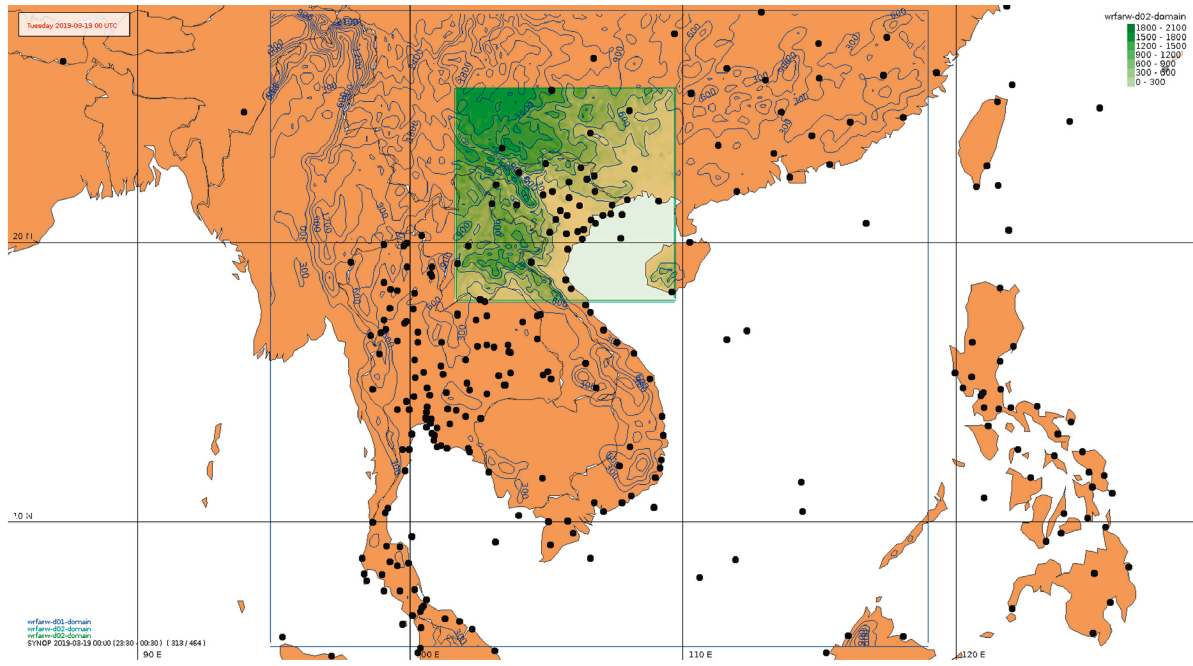
Figure 2: SYNOP station distribution over Vietnam and closed countries (black dots) and terrain of computing domains for the WRF-ARW model. The blue contour is for the outer domain (d01, 15km), and dark green shading is for the inner domain (d02, 5 km), illustrated by the Diana meteorological visualization software of the Norwegian Meteorological